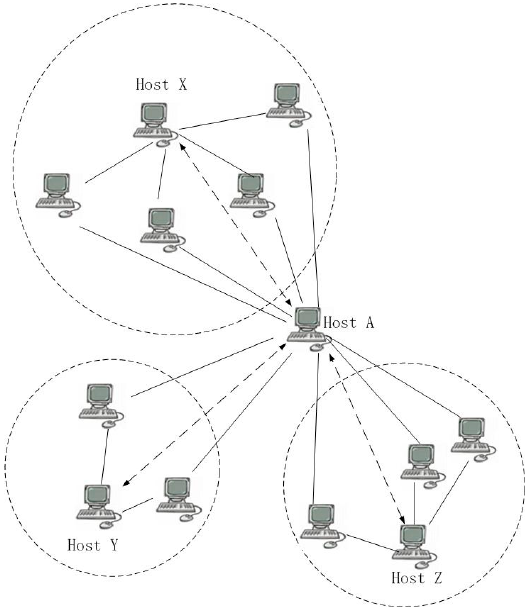
Figure 3. Network connection analytical model 2 . Information 2019 , 10 , x FOR PEER REVIEW